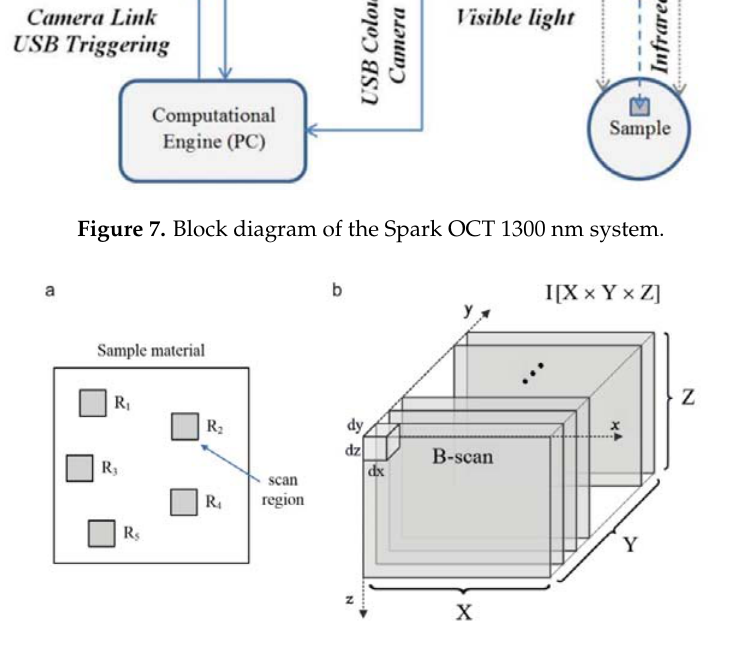
Figure 8. Acquiring images of the composite material samples: ( a ) random selection of imaging regions; ( b ) OCT imaging of region R k as a stack of XZ planes ( B -scans) acquired using a Spark OCT 1300 system; R k , k ∈ [ 1,5 ] —top view of a scanned image region; dx , dy , dz —dimensions of each